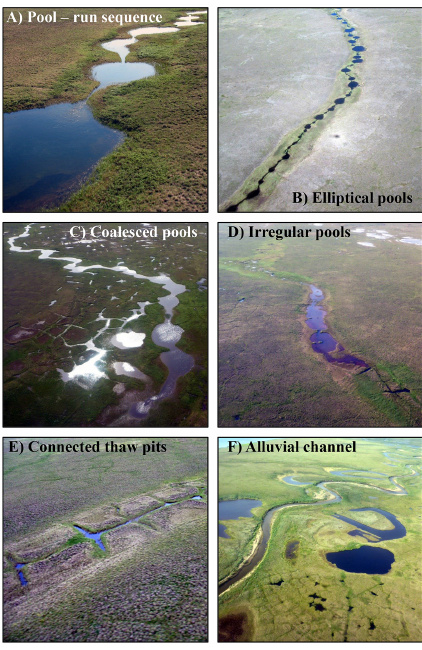
Figure 4. Oblique photographs showing typical pool-run morphol- ogy (a) and examples of beaded channel forms (b–e) compared to alluvial channel (f)